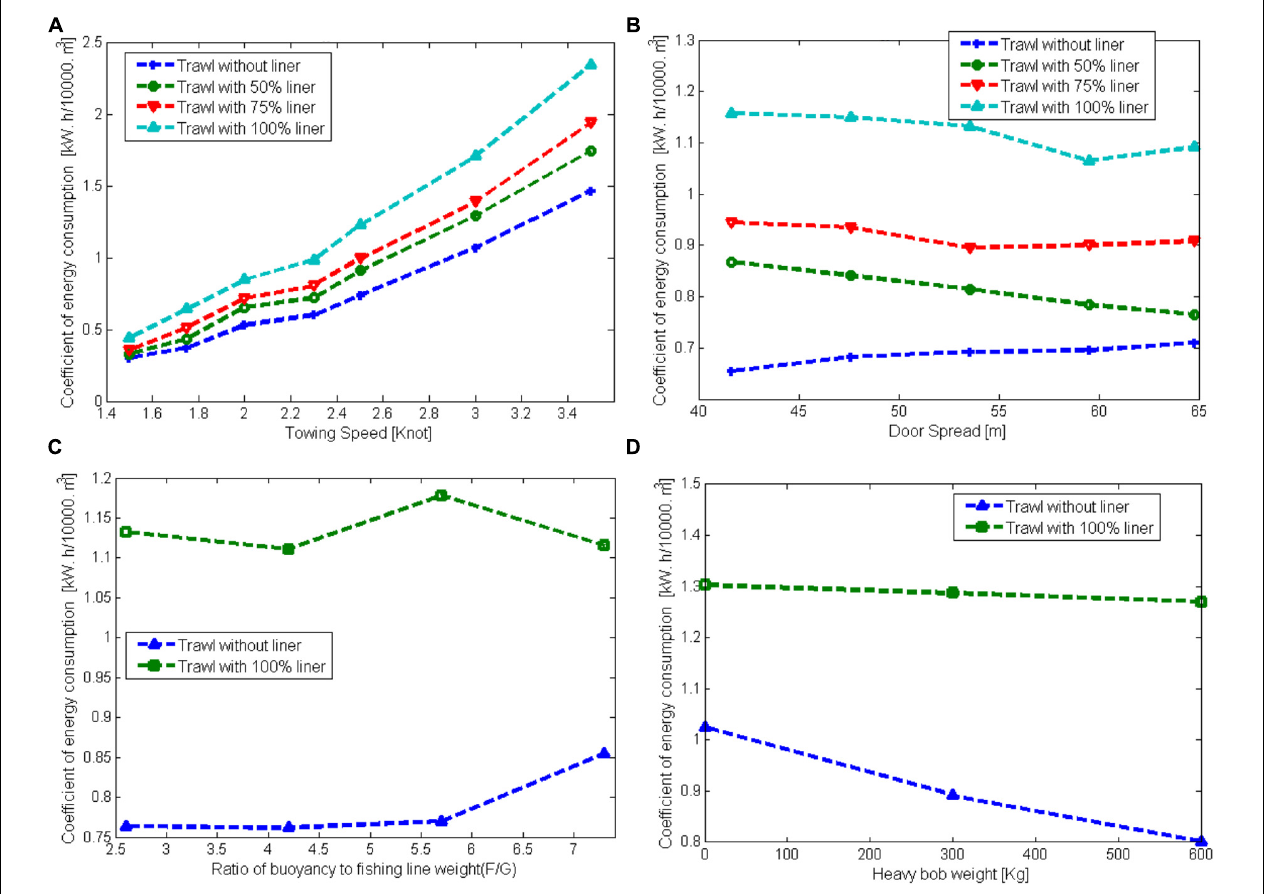
FIGURE 6 | Coefficient of energy consumption of the different trawls about the (A) towing speed, (B) door spread, (C) ratio of buoyancy to F / G , and (D) heavy bob weight: current data estimated with 95% confidence intervals from the statistical analysis.